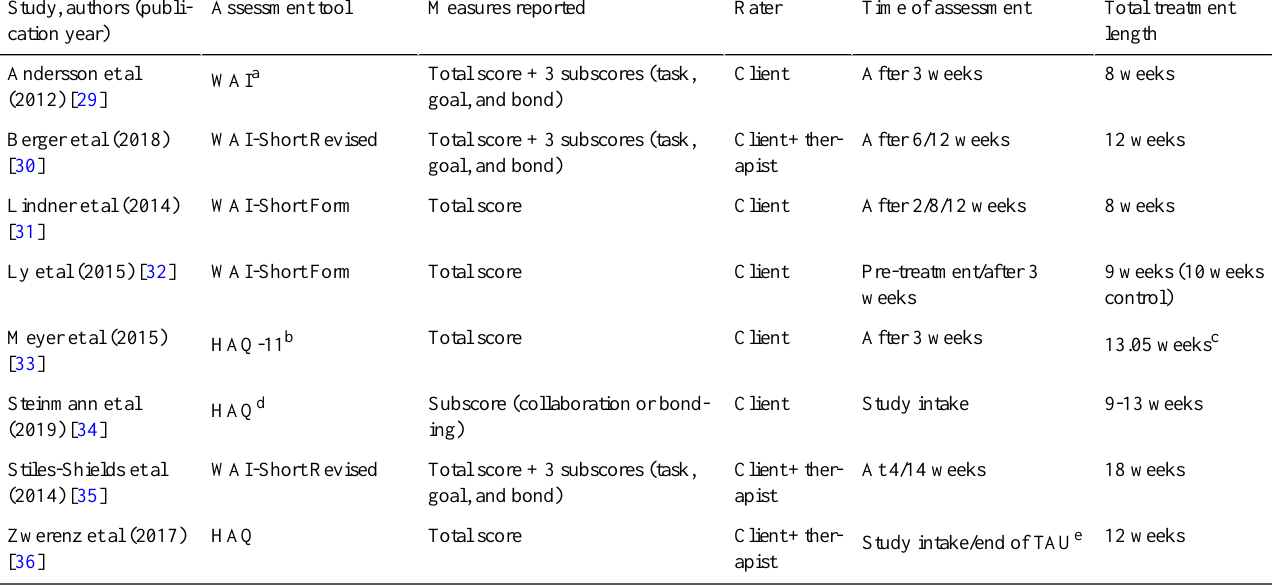
Table 3. Assessment of therapeutic